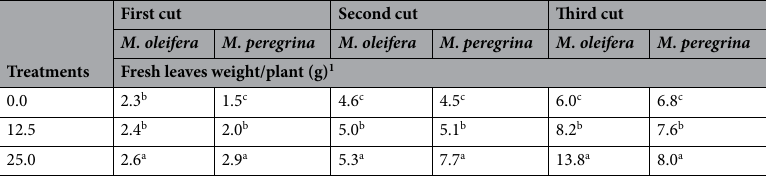
Table 5. The effect of selenium fertilization (mg Se/L) on fresh leaves weight of M. oleifera and M. peregrina at different cutting periods. 1 Means within each column with the same superscripts were not significantly different using Duncan Multiple Range Test at the 0.05 level of significance.